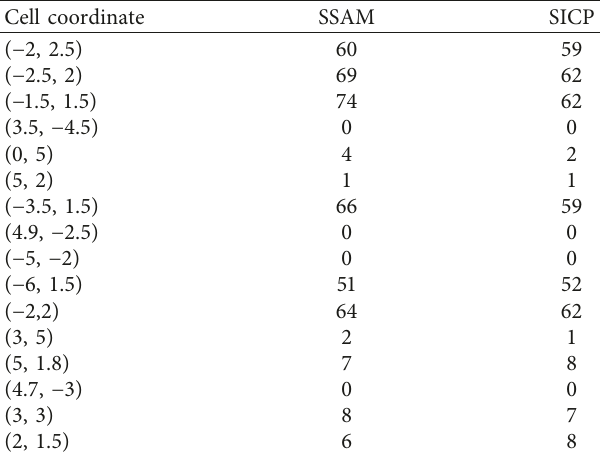
Figure 6: Comparisons between SSAM and SICP model. (a) The distribution of traffic conflict predicted by SICP. (b) The distribution of traffic conflict predicted by Table 4: Comparison of conflict number between SSAM and SICP model.